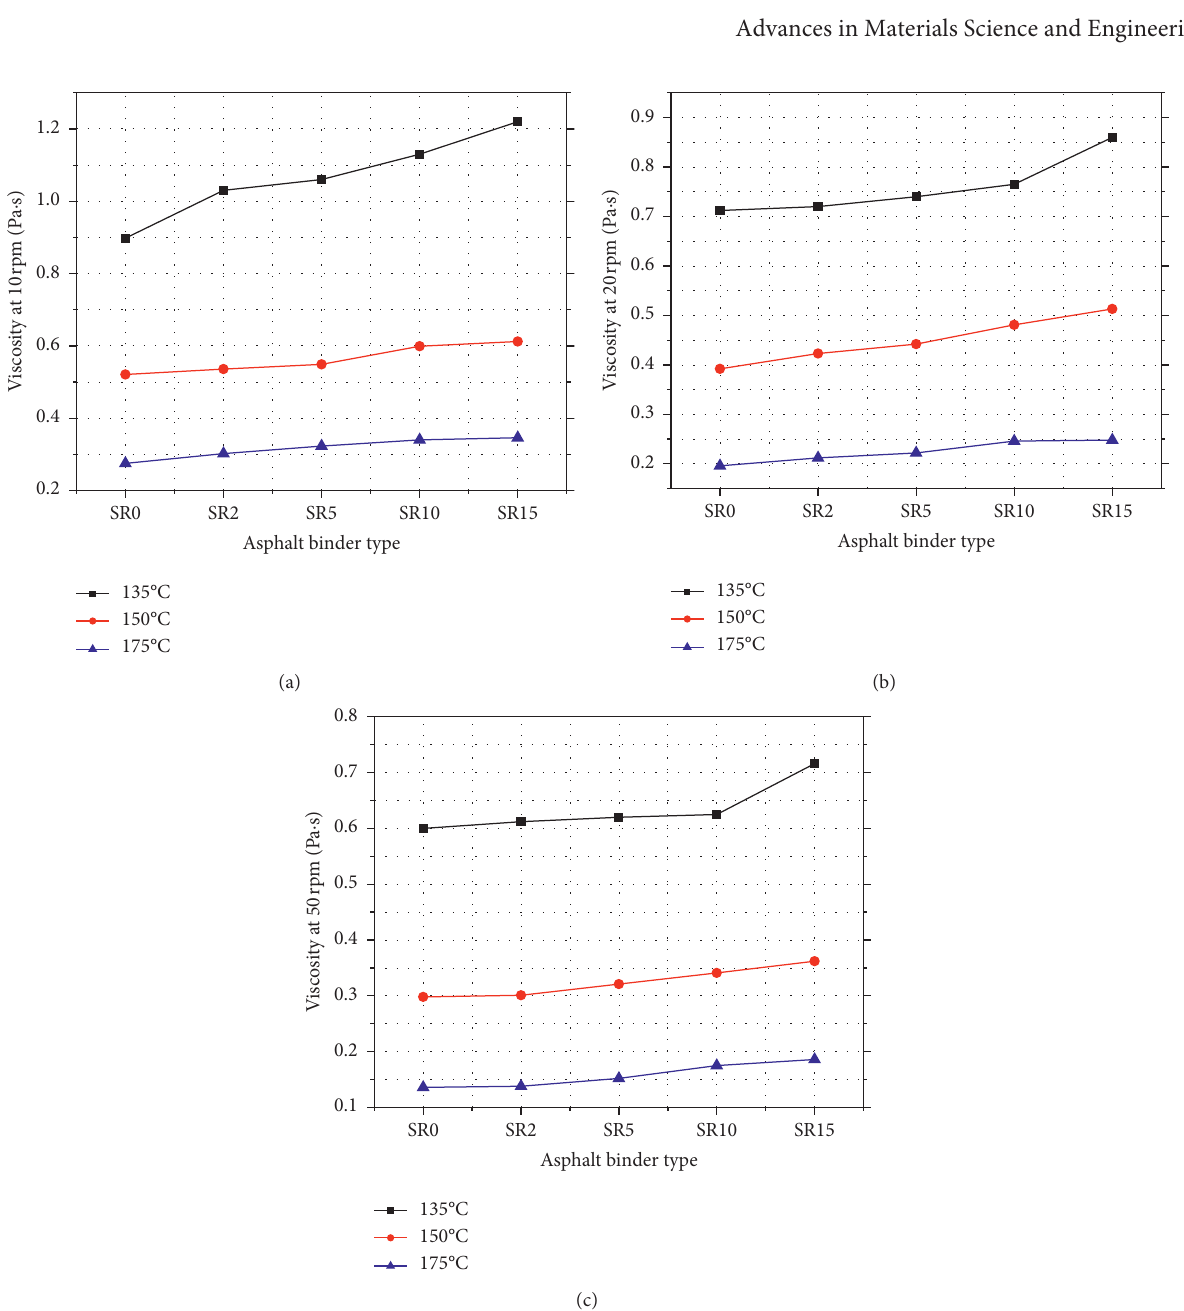
Figure 6: The viscosity of different asphalt binders at different rotational speeds: (a) at 10rpm; (b) at 20rpm; (c) at